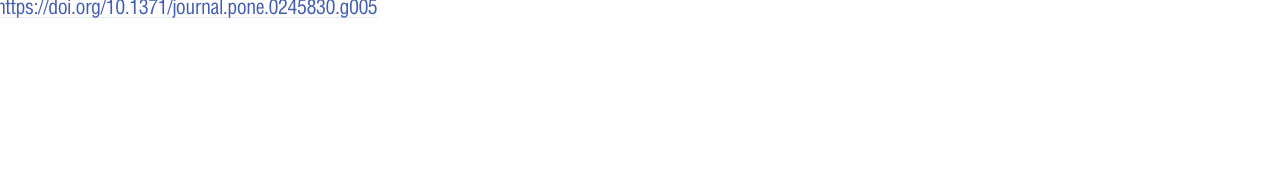
PLOS ONE | https://doi.org/10.1371/journal.pone.0245830 January 29,